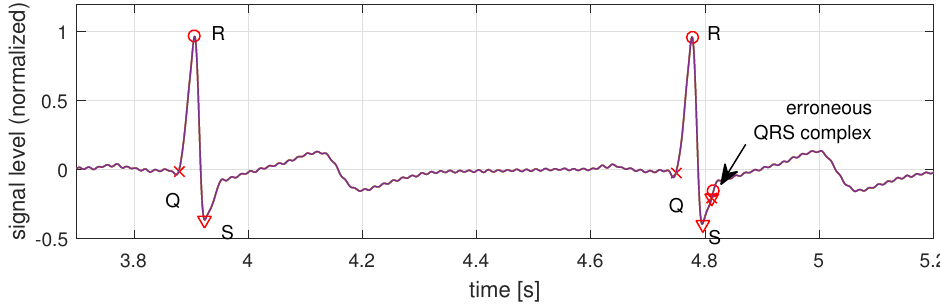
Figure 7. Signal and detected QRS peaks for two QRS complexes after Pan-Tompkins. Note that a third erroneous QRS complex is detected at time stamp 4.8